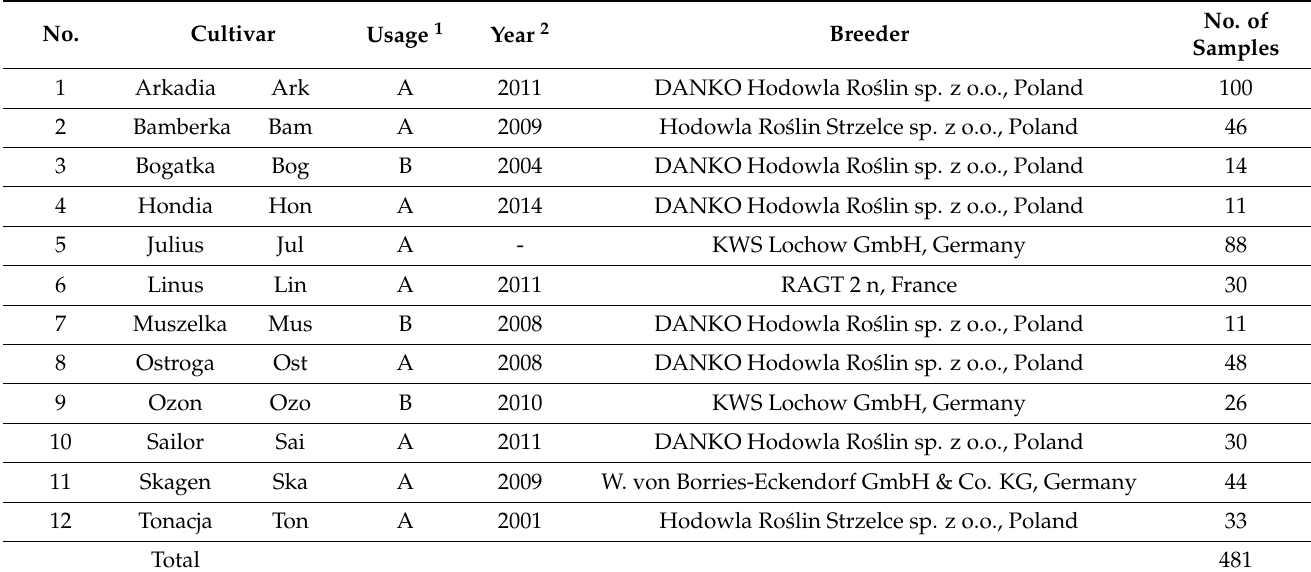
Table 1. Characteristics of wheat cultivars and the number of samples taken.